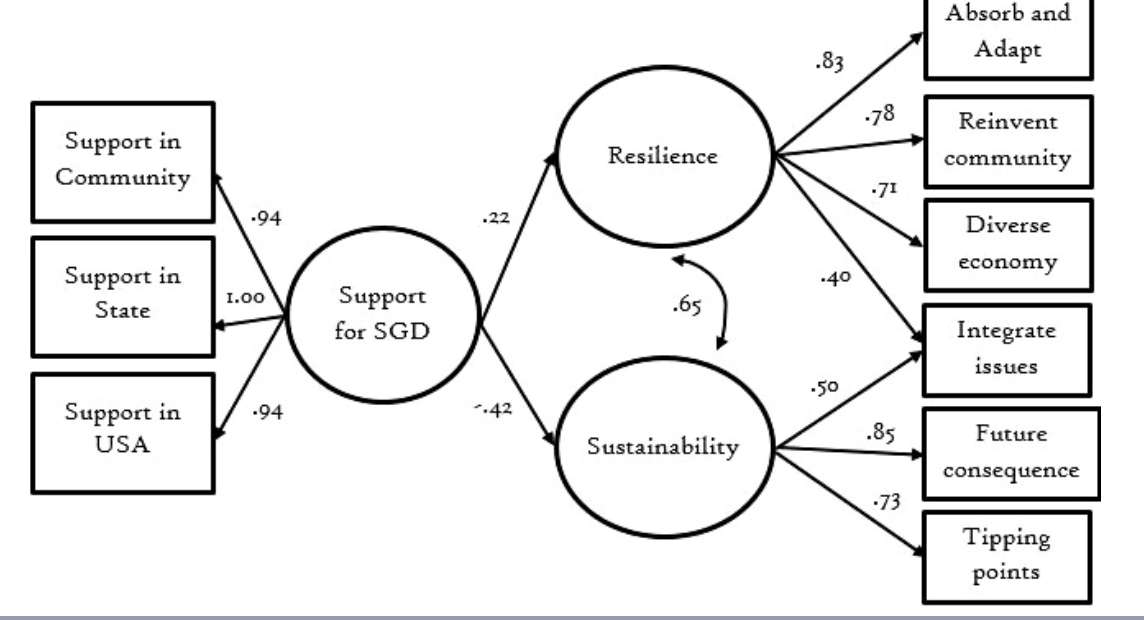
Fig. 1 . Structural equation model; effects of support for/opposition to shale gas development on importance of sustainability and resilience. Rectangular boxes represent measured variables from the survey, ovals represent latent variables generated from the boxes to which the associated arrows point; coefficients on pathways from ovals to boxes represent factor loadings, coefficients on pathways from ovals to ovals represent standardized beta coefficients as in a regression; the curved arrow is an error covariance between the residuals for the latent variables representing sustainability and